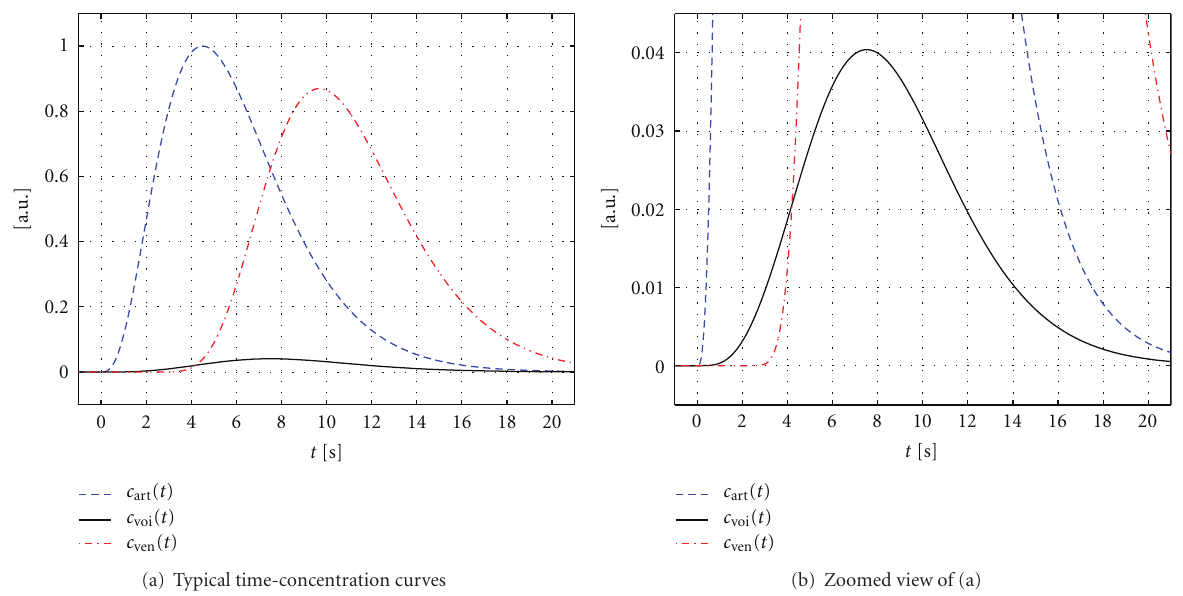
Figure 3: Examples of the time-concentration curves c art ( t ), c voi ( t ), and c ven ( t ) given in arbitrary units (a.u.). (b) Represents a zoomed view of (a) with a rescaled